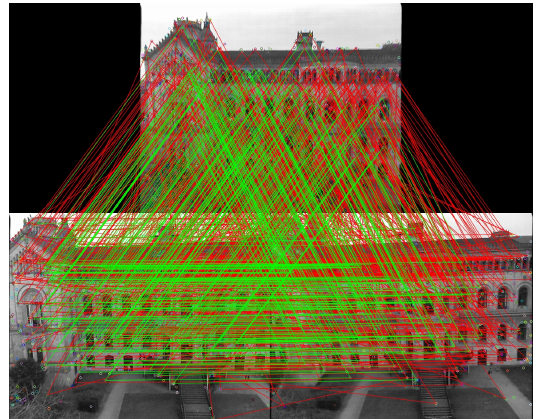
Figure 1: Triplet matching results after refinement by the trifocal tensor. Accepted matches are shown in green, rejected matches are shown in red colour.